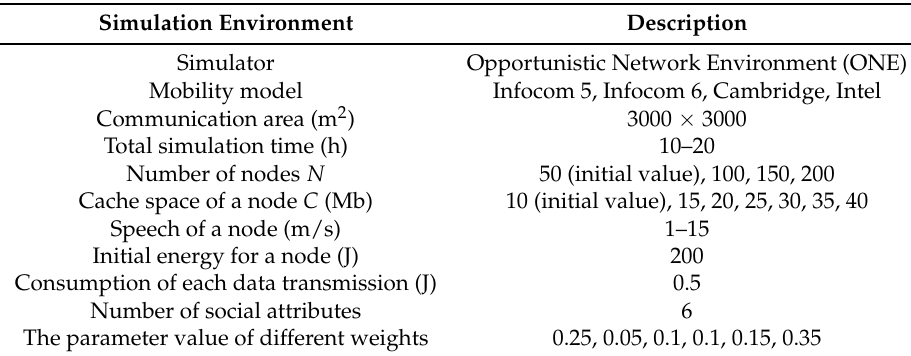
Table 2. The experimental setting of simulation